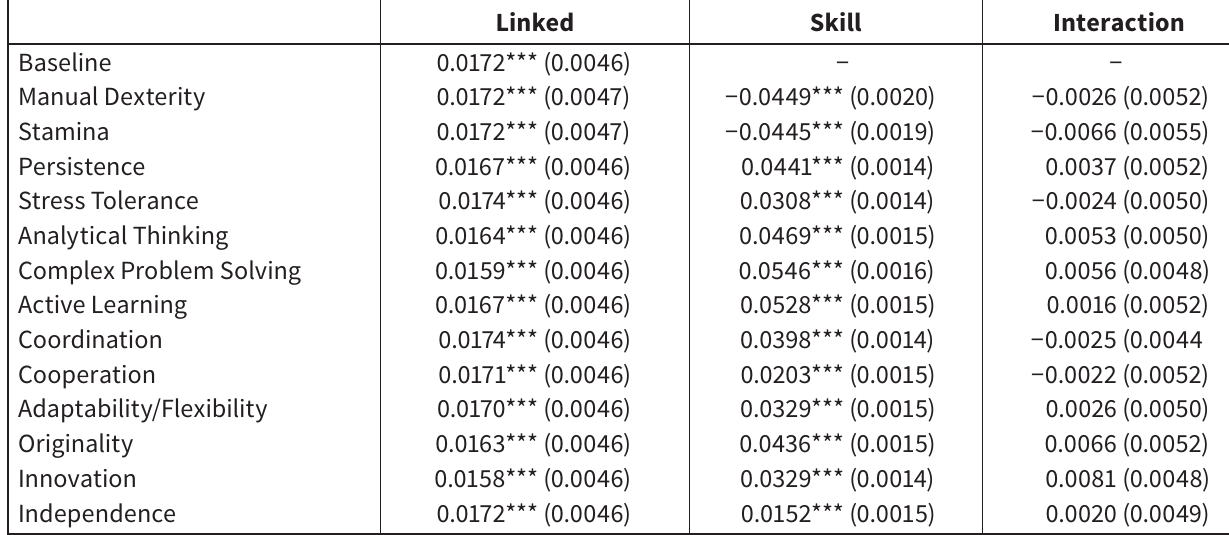
Co-worker gains and skill requirements Linked